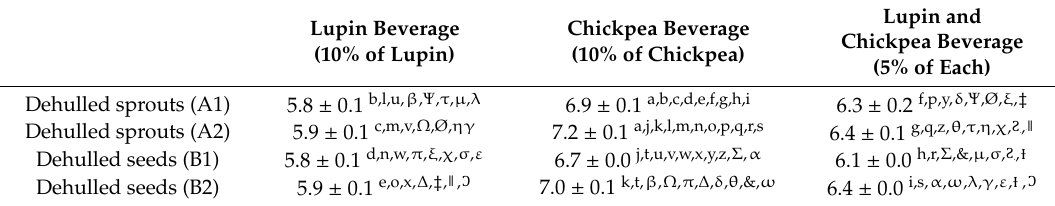
Table 1. Average of pH values obtained during the 7 days storage at 4 °C of pulse beverages obtained from the processing procedures A and B, when included the dehulling after cooking (where the subscript “1” corresponds to beverages with cooking water and “2” to beverages with new water). The same superscript letter/symbol in beverage-pairs evidences significant difference between them ( p < 0.05). Values are represented as mean ± standard deviation.